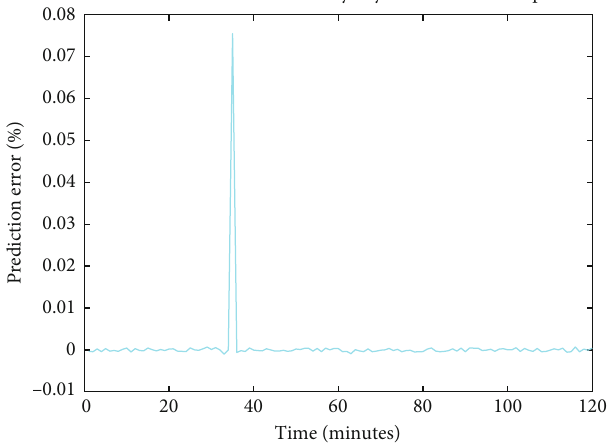
Figure 26: Prediction error vs. time for cloudy day two-hour-ahead